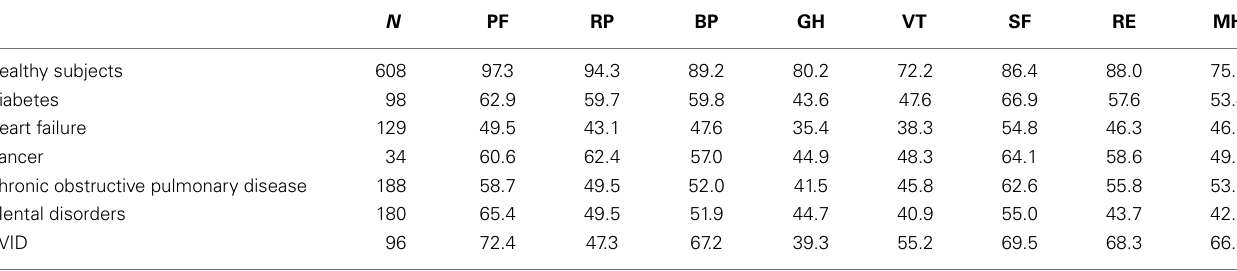
Table 2 | Mean values of SF-36 scales for CVID patients compared with healthy subjects and with patients with different chronic diseases in Italy